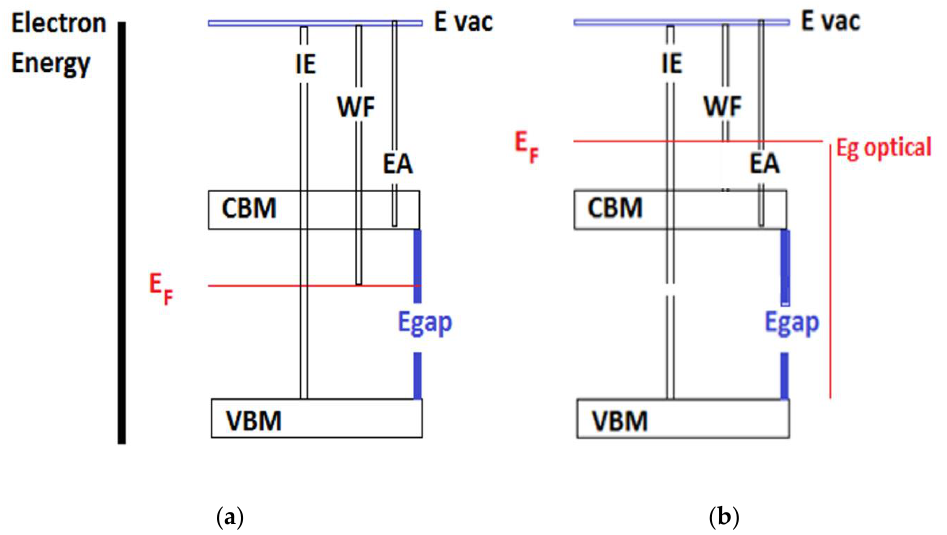
Figure 1. ( a ) A simple flat band representation of the energy band at the surface of a semiconductor (assuming no net charge accumulation at the surface). The ionization energy (IE), work function (WF), electron affinity (EA), fermi level ( E F ), bandgap ( E g), optical gap ( E g Optical), conduction band minimum (CBM) and valence band maximum (VBM) are simply defined; ( b ) the schematic diagram showing the optical widening of the transparent conducting oxide (TCO) bandgap using the Moss-Burstein shift, E gMB .